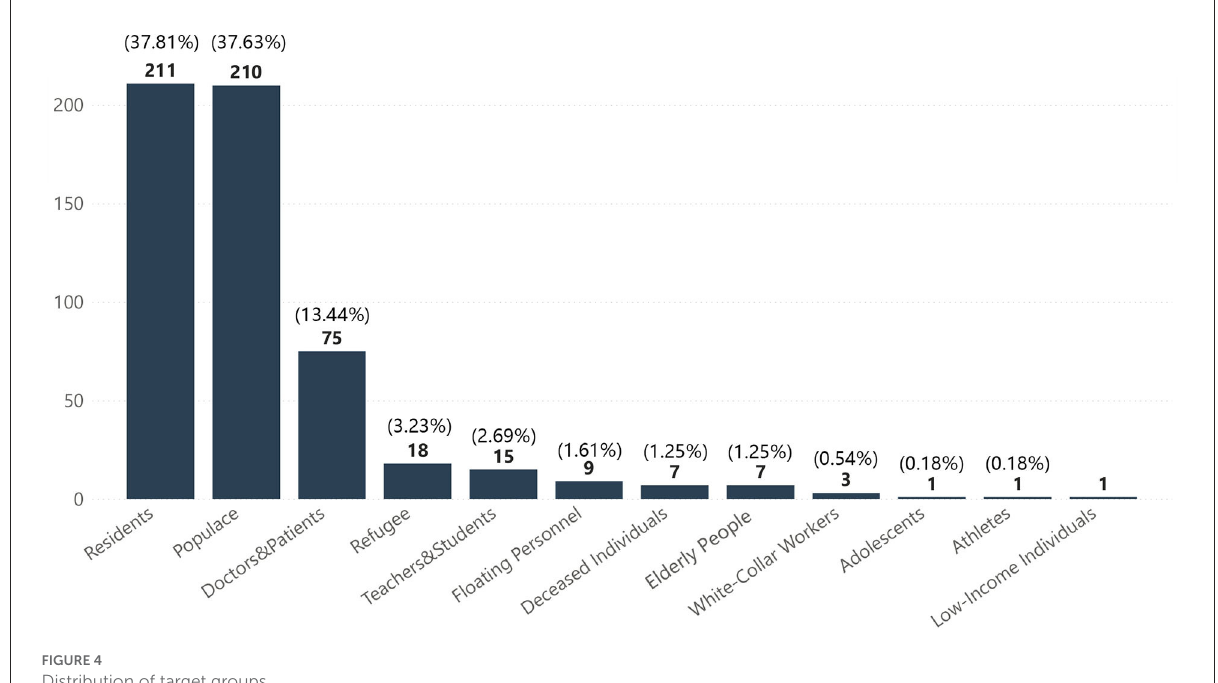
FIGURE4 Distribution of target groups.